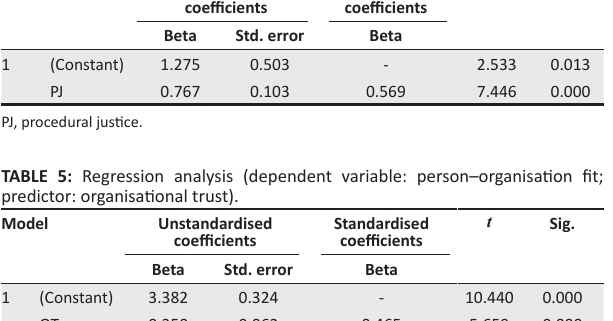
TABLE 4: Regression analysis (dependent variable: organisational trust; predictor: procedural justice). Model